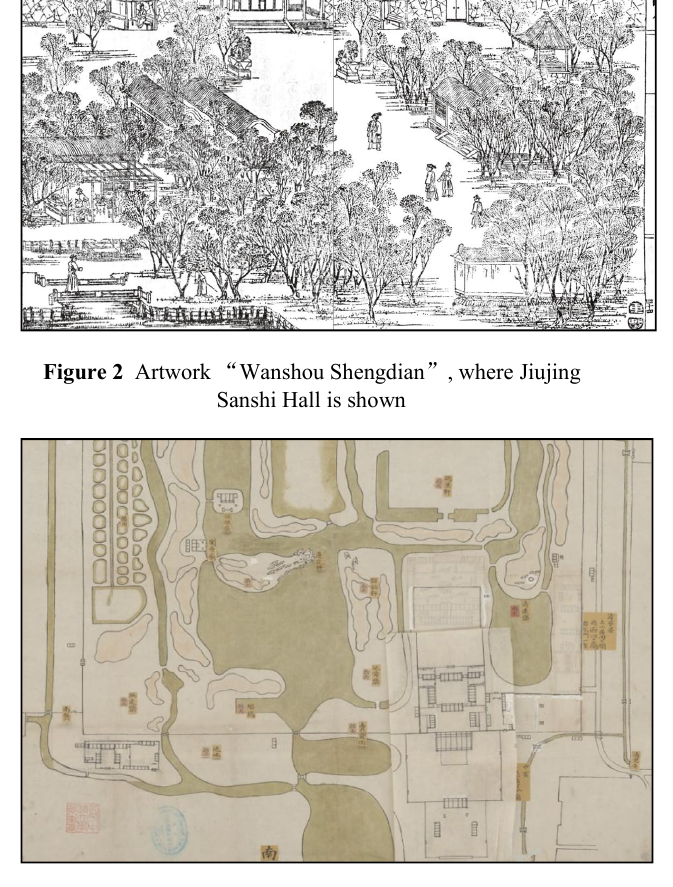
Figure 3 Full map of the Changchun Garden site – Jiujing Sanshi Hall